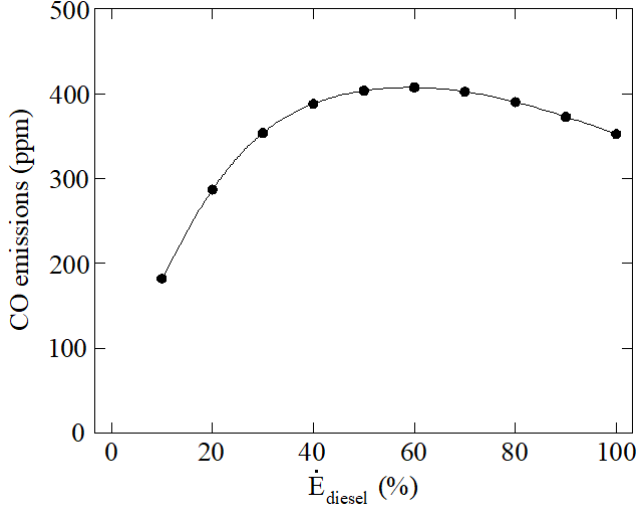
Figure 6. CO emissions against the power contribution from diesel fuel.